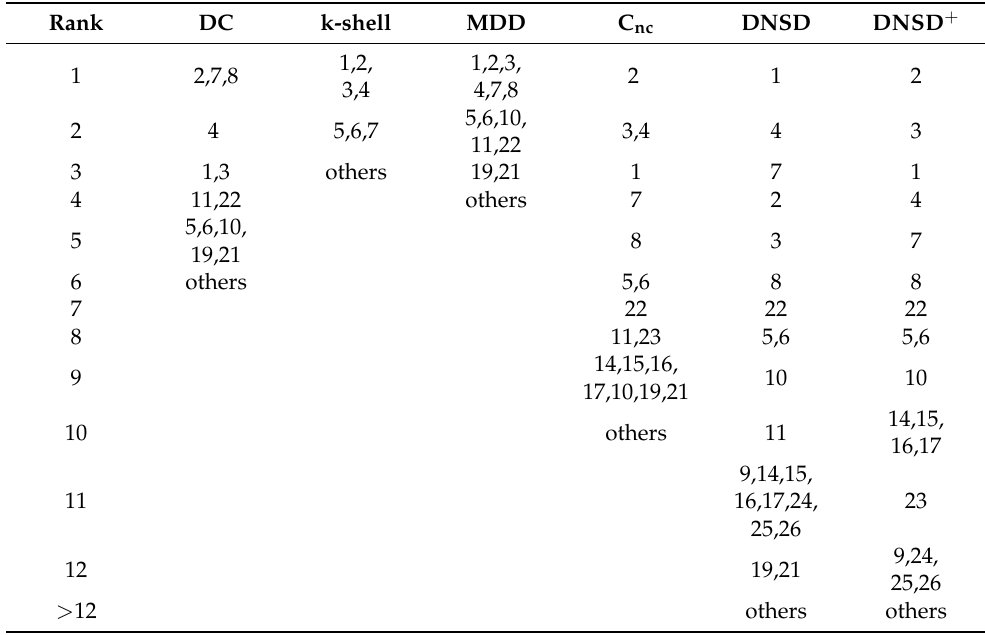
Figure 1. A sample network with 26 nodes. The results of different methods in the sample network are shown in Table 1. Table 1. The ranking lists of the sample network in Figure 1 measured by different methods. α is set to 0.5 and β is set to 0 simply. The ranks greater than 12 are not